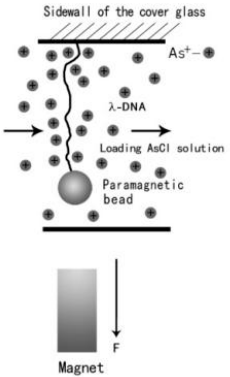
Figure 1. A schematic diagram of magnetic tweezers.